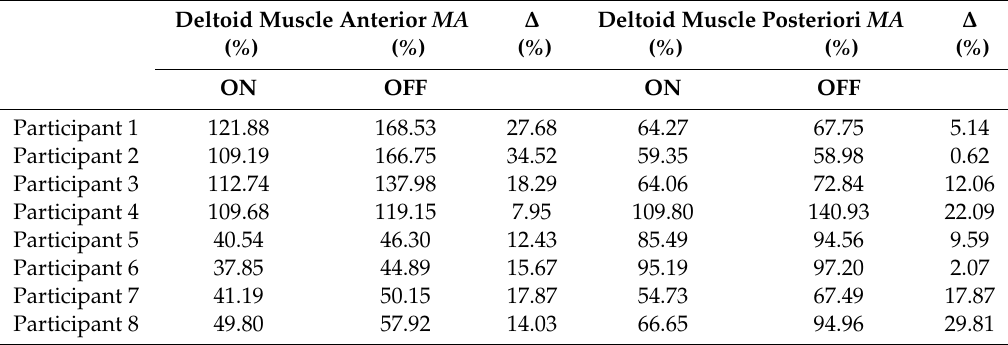
Table 6. The comparison of the average muscle activity of deltoid muscle anterior and deltoid muscle posteriori for respective participants, where MA —muscle activity, ON—activated anti-rollback system, OFF—deactivated anti-rollback system, ∆ —a percentage di ff erence between muscle activity measured with the activated anti-rollback system and the deactivated anti-rollback